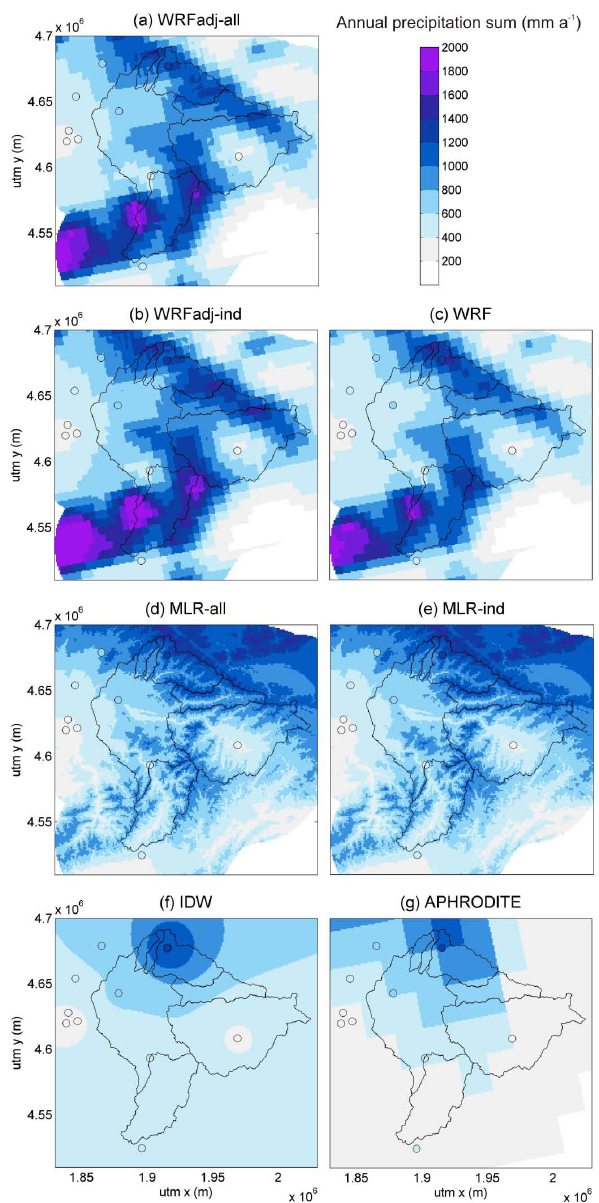
Fig. 4. Estimates of the mean annual precipitation (1960–1990) over the Karadarya catchment using different methods. Circles indicate measured precipitation at stations. Lines indicate subcatchment bor- ders.